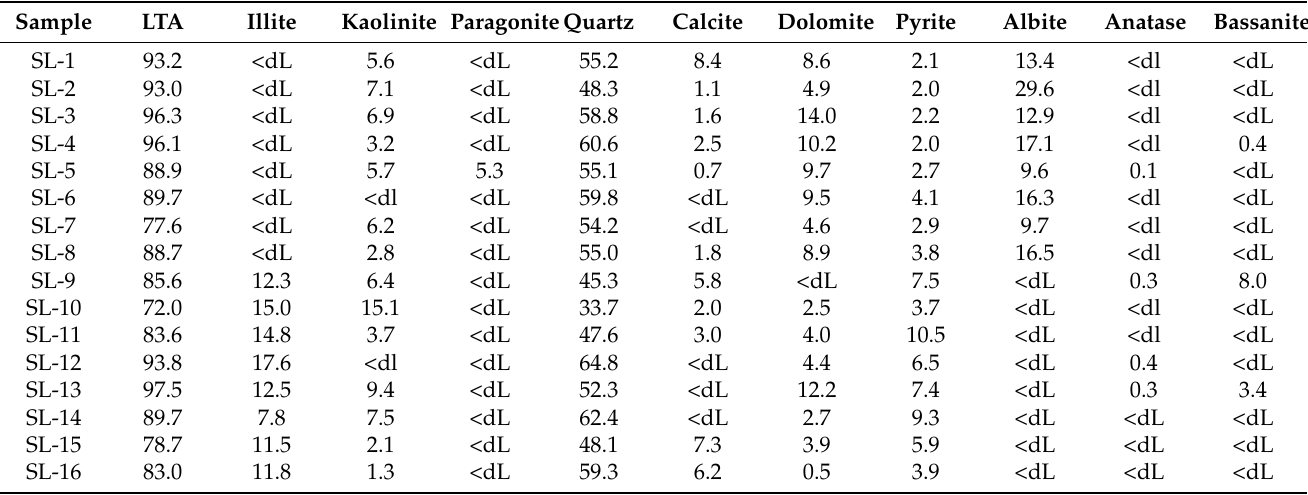
layers A–C (Figure 5). Table 2. Mineralogical proportions and low-temperature ash yield (LTA) of the samples from the borehole SL (on whole-coal basis; unit in wt%).